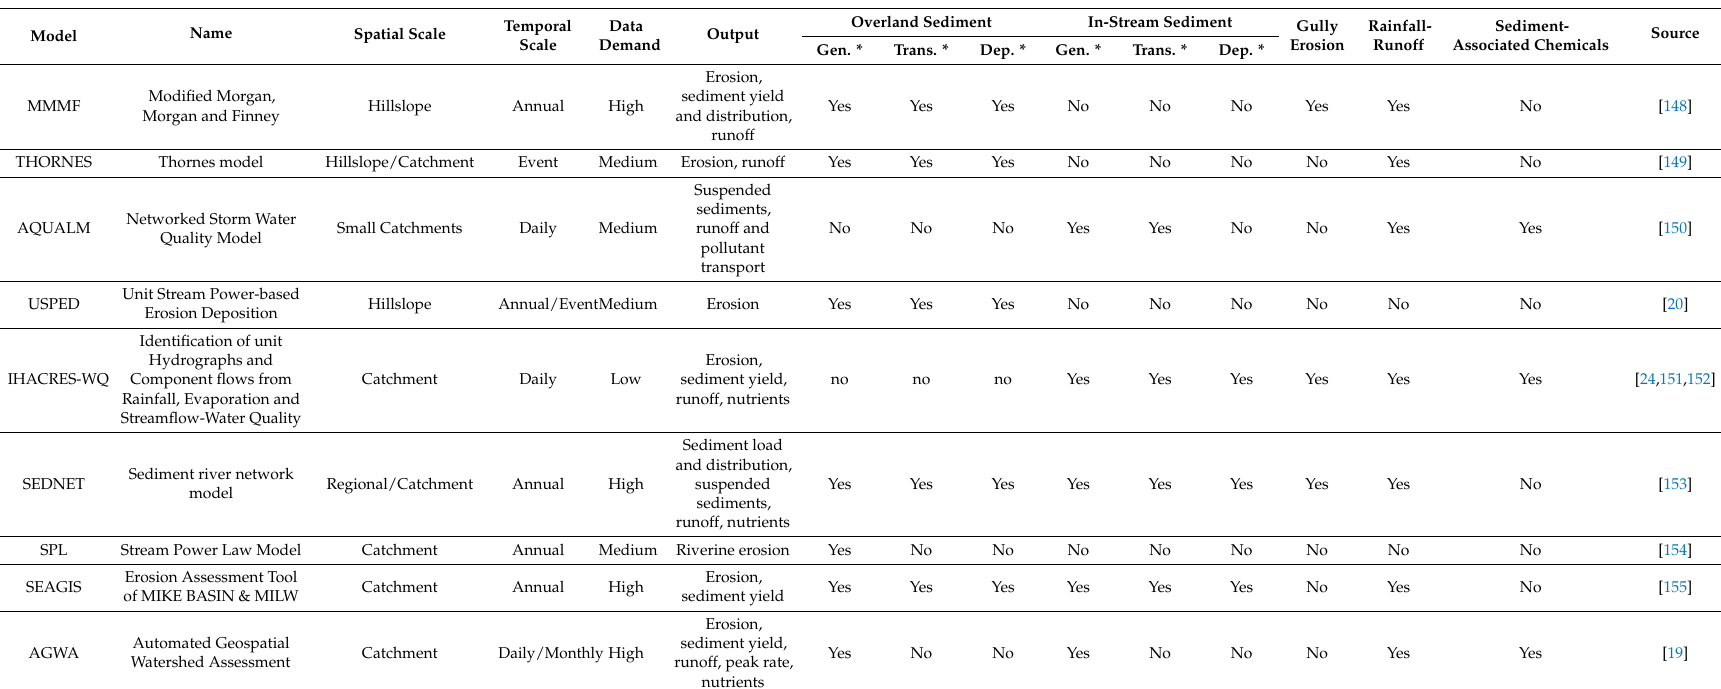
Table 4. Hybrid soil erosion